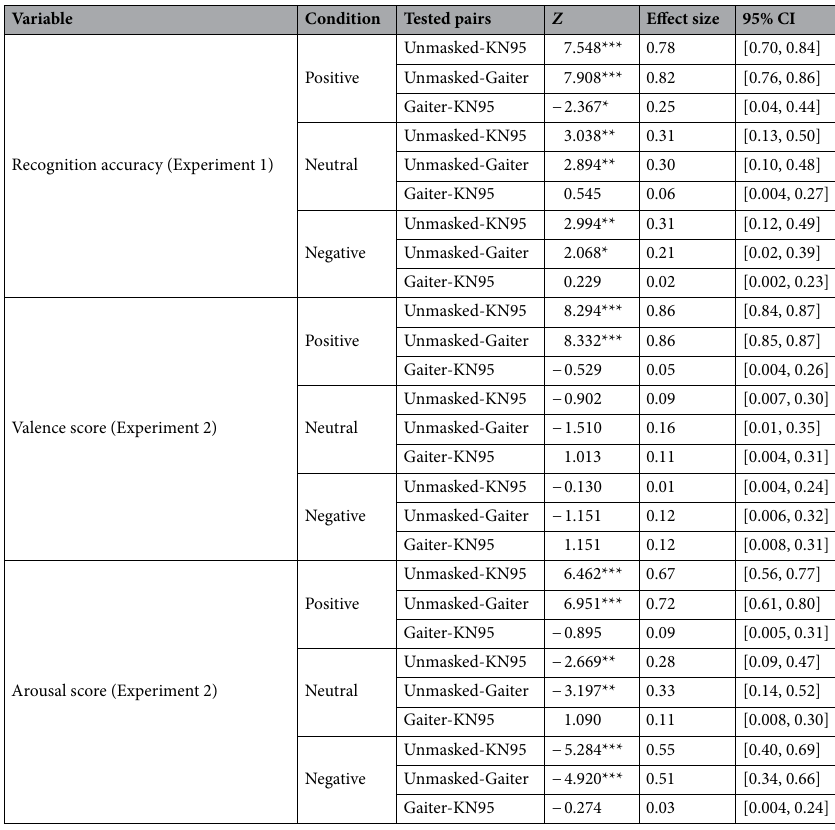
Table 1. Friedman tests post-hoc analysis for Experiments 1 and 2: Wilcoxon signed-rank tests (Bonferroni corrected) were used to compare pairs of the three conditions. Effect sizes were calculated by diving the Z value by the square root of N . Note that the groups in Experiments 1 and 2 were independent, and each was of size N = 93. *** p < 0.001, ** p < 0.01, * p < 0.05.